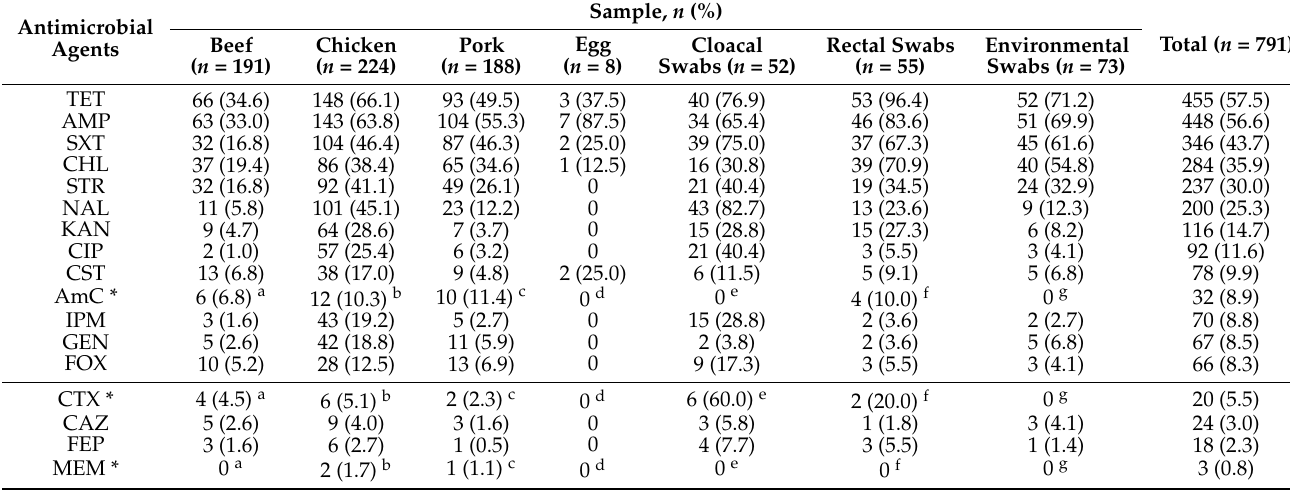
Table 2. Antimicrobial resistance profiles of E. coli isolates in samples. Antimicrobial